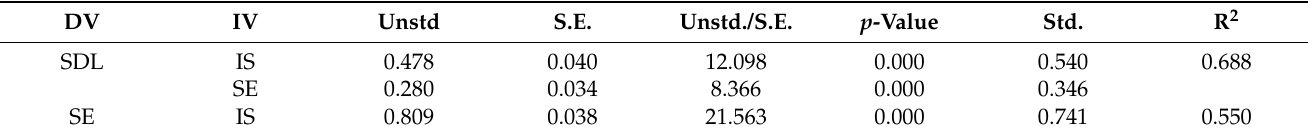
Table 7. Regression